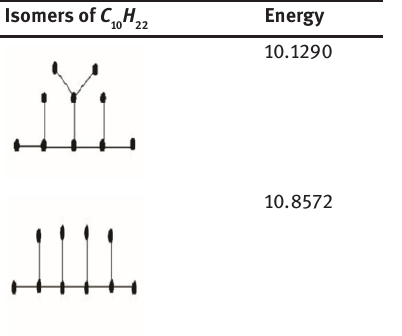
Table 2: The values of energies of different isomers of C Isomers of C